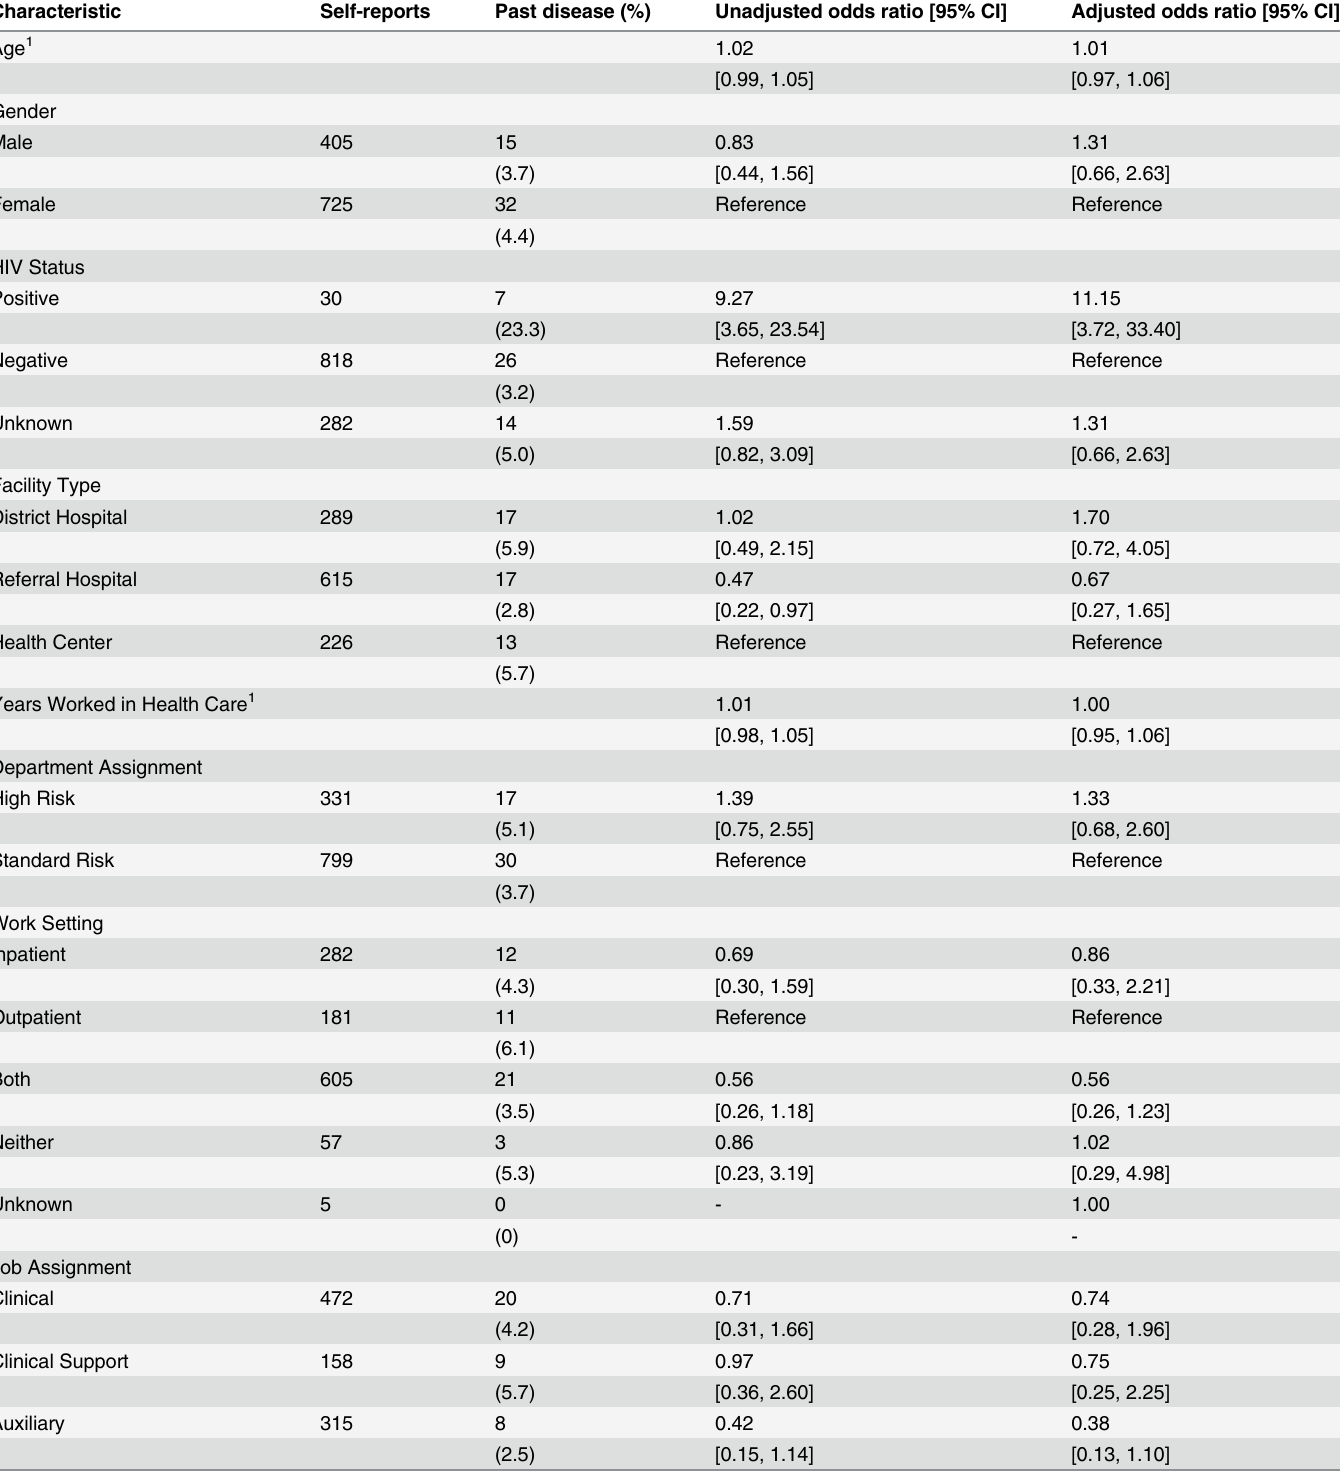
Table 5. Associations between self-reported history of TB disease and presumptive risk factors for health facility workers from Kigali, Rwanda.